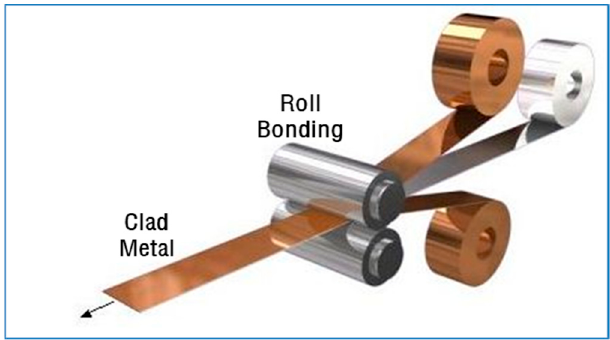
Figure 2. Schematic illustration of the roll bonding process for manufacturing three-ply clad metals [4].